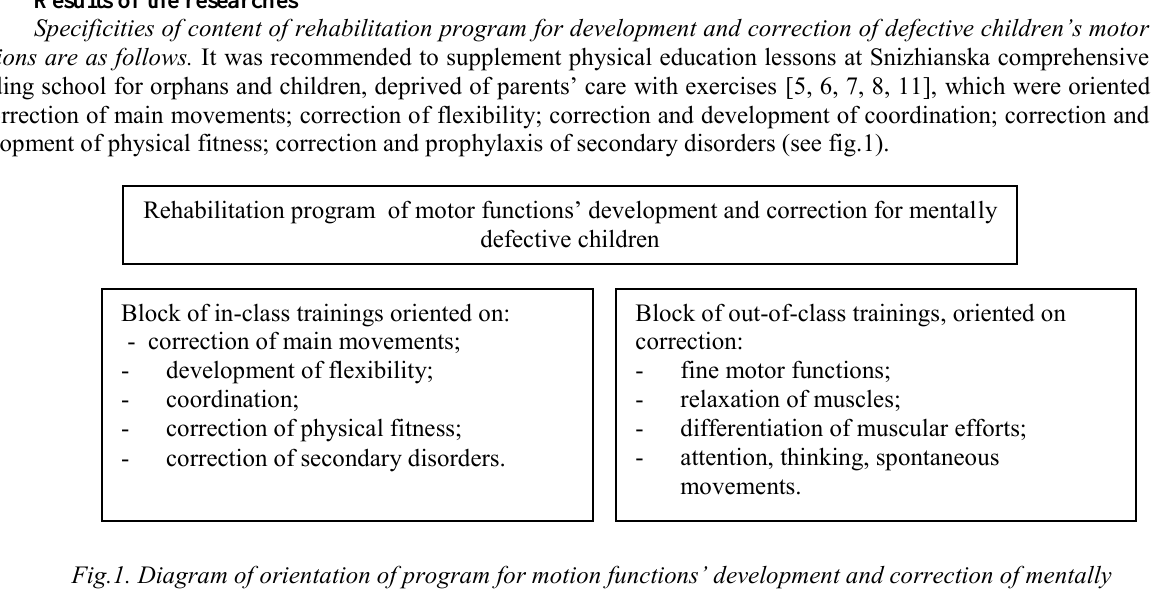
Fig.1. Diagram of orientation of program for motion functions’ development and correction of mentally defective